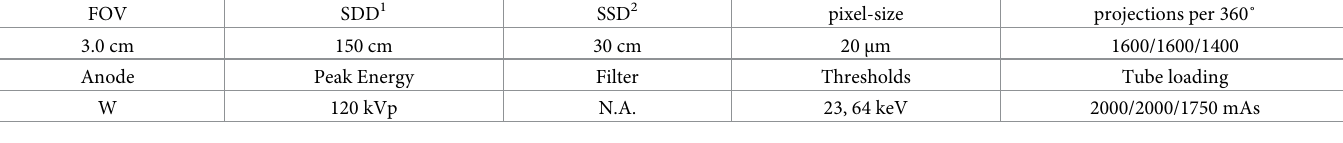
Table 1. CT geometry and image parameters of the performed tomographic scans. The field-of-view (FOV) and the pixel-size are given at the isocenter. Projections per 360˚ and the tube loading are given for the different samples: rod phantom / concrete drill core/ ethernet